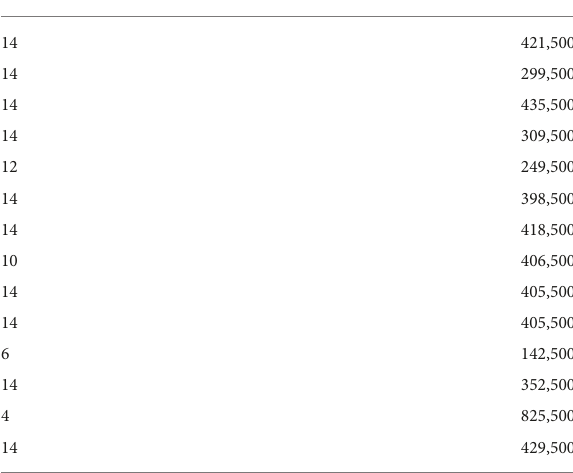
TABLE 4 The specific interaction sites of YRR1 in EMV-8, compared to NAN-27. Chromosome number